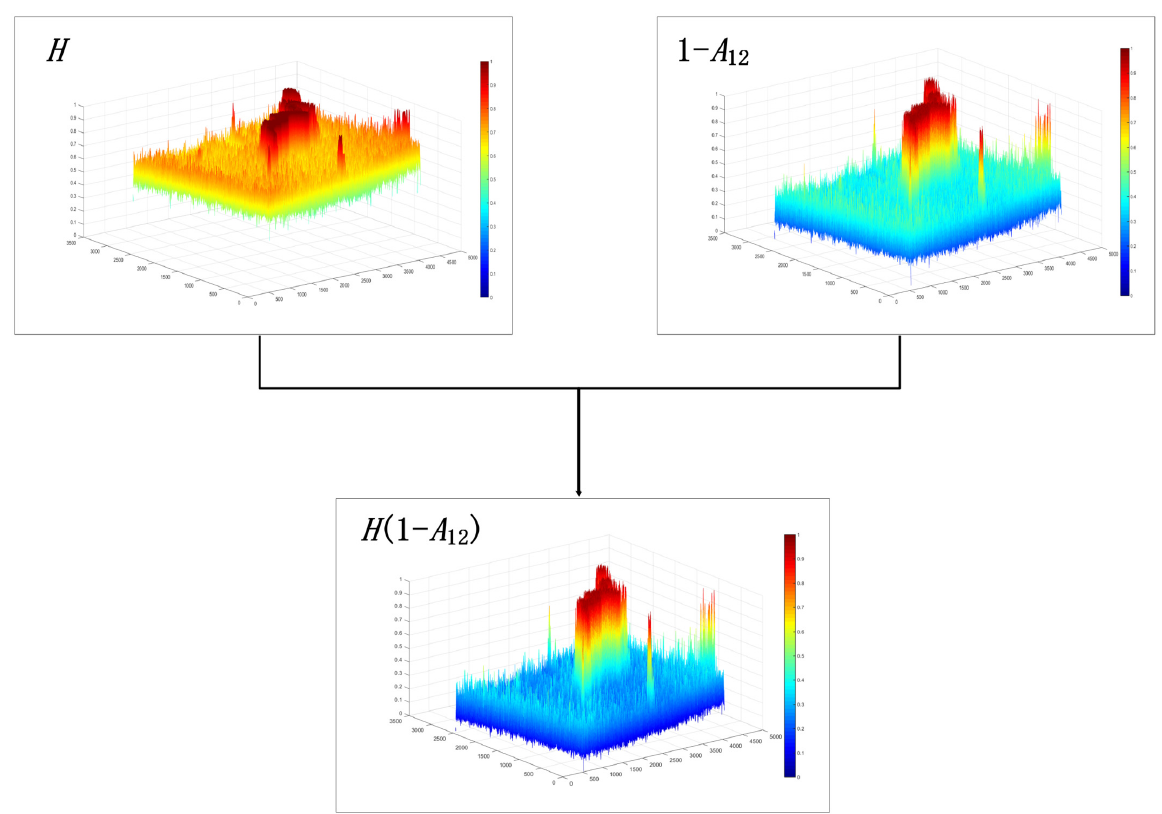
Figure 4. Schematic showing the combined polarimetric parameter H (1 − A 12 ) of natural oil seeps in case 1 .